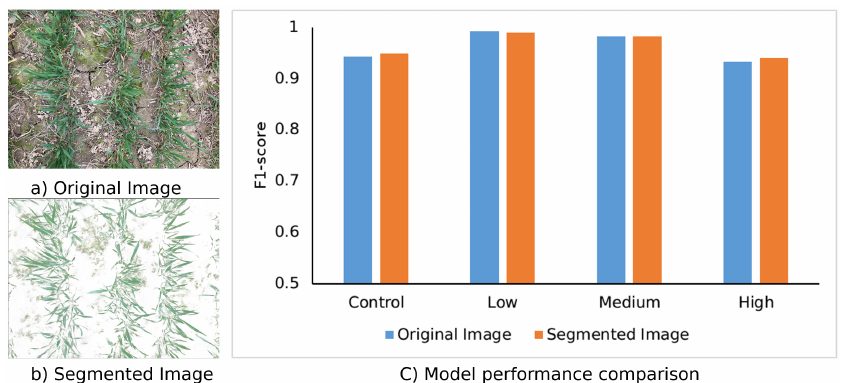
Figure 10. ( a ) is the original image and ( b ) is the segmented image without soil. ( c ) shows the model performance with original and segmented